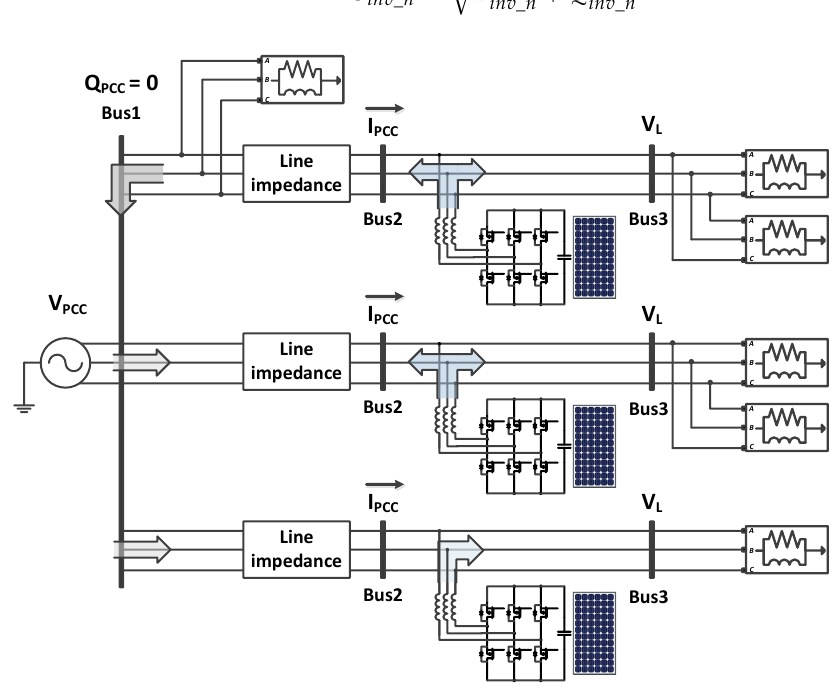
Figure 4. Configuration Scheme of the Virtual STATCOM System.